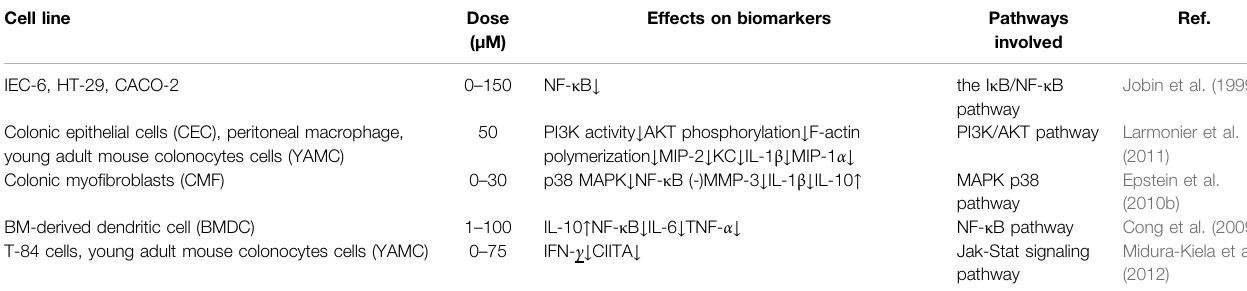
TABLE 3 | Details of curcumin ’ s role in in fl ammatory bowel disease treatment in vitro . Cell line Dose